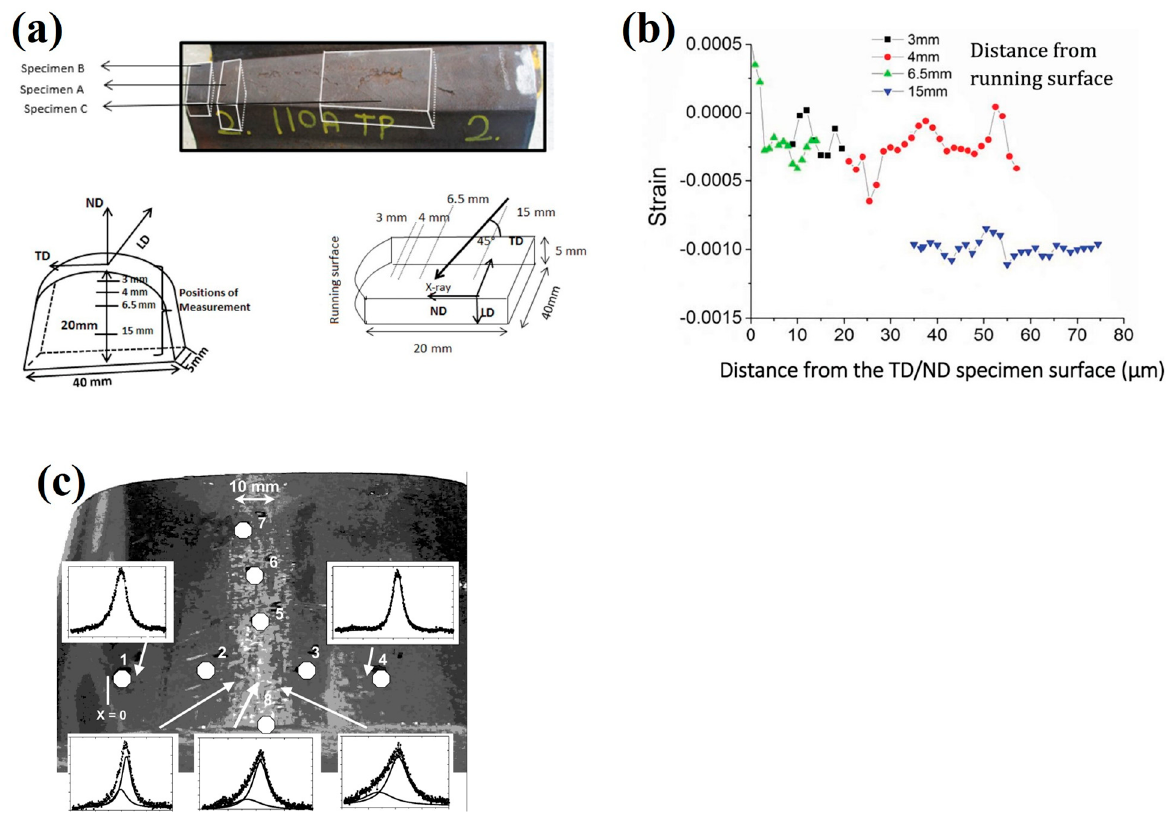
Figure 8. Studies by Dhar et al. [70] showing ( a ) the extraction of a sample from a railway crossing for synchrotron residuals stress analysis and ( b ) measurements taken different locations from the running surface indicating tensile and compressive strains. ( c ) Strain measurement locations on the rail head by Pyzalla et al. [73] for white etching layer analysis. Table 1. Synchrotron facilities with rail component residual stress measurement